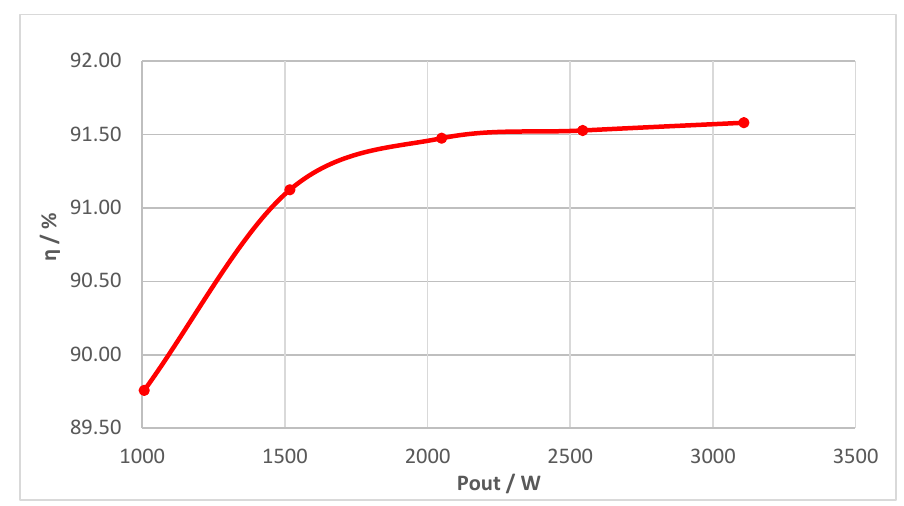
Figure 24. Efficiency as a function of output power for SiC MOSFETs.